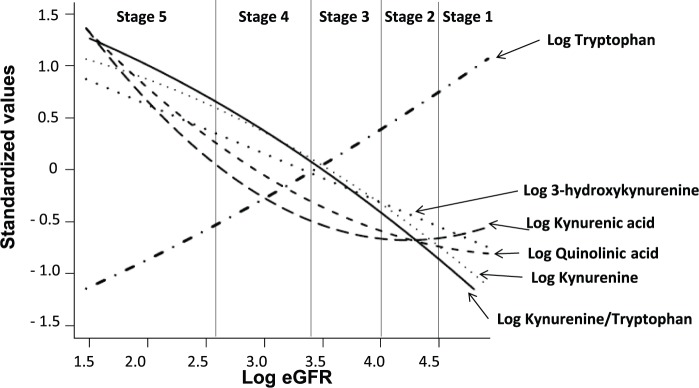
Relationship between kidney function and tryptophan metabolites.aaPenalized smoothing splines were used to assess the relationship between eGFR to tryptophan metabolites. eGFR indicates estimated glomerular filtration rate.